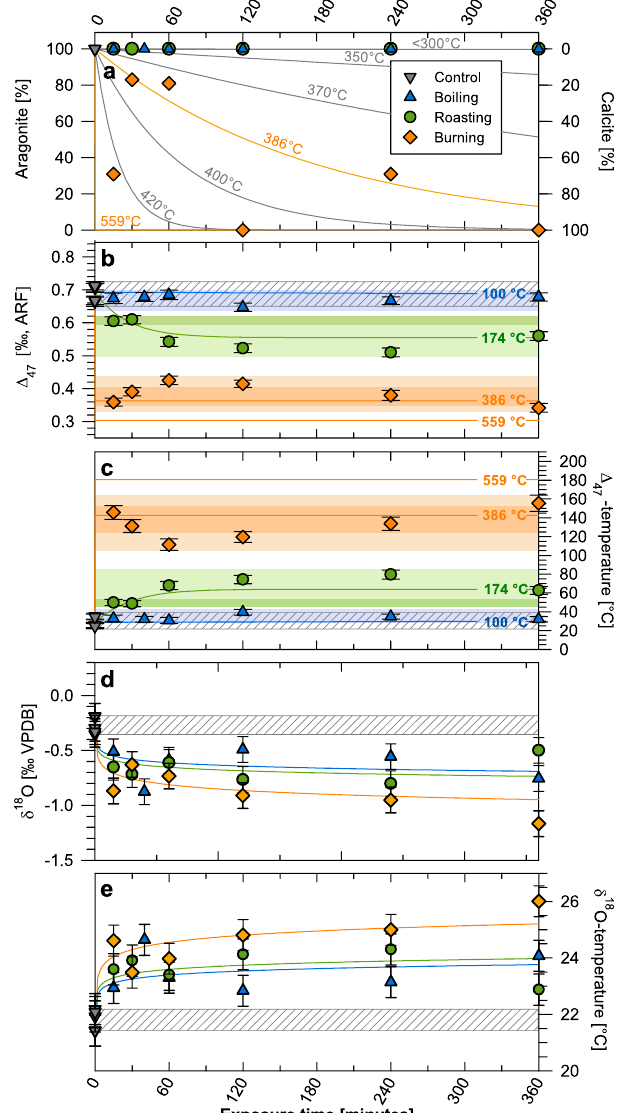
Figure 2. Alteration of mineralogy and geochemical proxies in modern Mercenaria campechiensis shells by simulated prehistoric cooking methods: Untreated (grey triangles and grey striped areas), boiled (blue triangles), roasted (green circles), and burned shells (orange diamonds). ( a ) Conversion of primary aragonite into secondary calcite with the predicted aragonite-calcite conversion based on the Arrhenius model for biogenic aragonite of Staudigel & Swart 29 (solid lines). ( b ) Clumped-isotopic composition ( Δ 47 ) reported in the absolute reference frame (ARF) defined by Dennis et al . 24 of the bivalve shells after exposure to the different cooking methods. Solid lines represent predicted Δ 47 values using the Arrhenius model of Staudigel & Swart 29 . Error bars represent mean standard errors of the individual measurements. The grey striped area represents the range of untreated control shells (n = 5). Shaded areas represent the characteristic Δ 47 windows for each cooking treatment over the entire experiment duration (light) and realistic cooking durations of < 30 minutes (dark). ( c ) Calculated Δ 47 -based water temperature estimated using the equation of Dennis et al . 24 and corresponding theoretical Δ 47 -based water temperature estimates predicted by the thermodynamic model of Staudigel & Swart 29 . Similar to panel (b), light and dark blue/yellow areas represent the characteristic Δ 47 - windows translated into water temperature. ( d ) Change in δ 18 O Shell over time of exposure for the different cooking methods. Solid lines represent exponentially fitted curves highlighting the overall trend towards lower 30 and δ 18 O δ 18 O Shell values. ( e ) Calculated Shell -based water temperatures using the equation of Grossman & Ku assuming a constant δ 18 O Seawater of 0.0‰